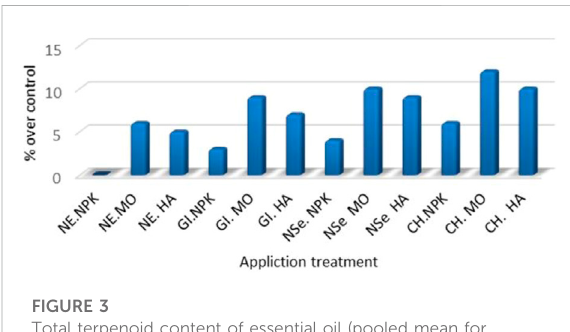
FIGURE 3 Total terpenoid content of essential oil (pooled mean for (2018 and 2019 seasons) as % of over control (NE NPK) under application